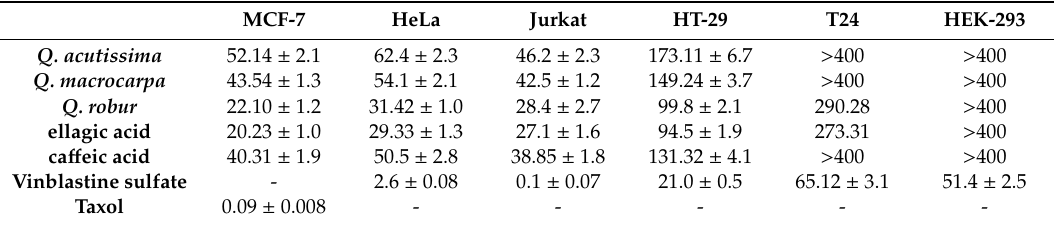
Figure 3. Apoptotic cell population (IC 50 ) using flow cytometry. Table 5. In vitro antiproliferative activity [IC 50 ( µ g / mL)] of Q. acutissima , Q. macrocarpa and Q. robur outer bark extracts as well as phenolic standards on cancer cell